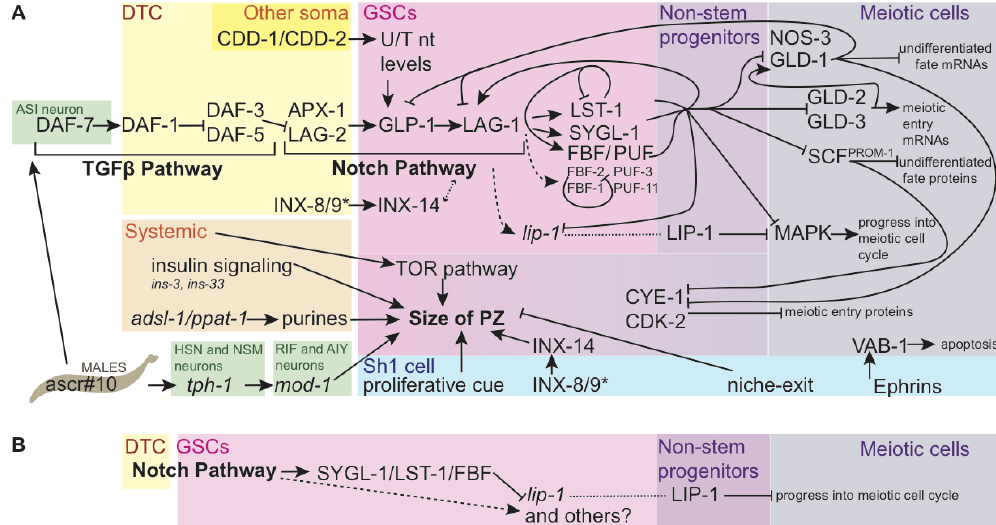
Figure 2. Genetic regulation of cell fate and size of the progenitor zone. ( A ) Genetic regulation of cell fate and size of the progenitor zone. Direct connections are indicated with solid black arrows. Indirect regulation is shown by dashed arrows. Pathway members are clustered with those that are thought to interact at the same step in the pathway, but lines originate and terminate only where there is genetic evidence of interaction. Coalescing arrows show cooperative activity at the next step of the pathway. GLP-1 Notch intracellular domain (NICD) is not shown separately. Colored boxes show sites of action for the genes and proteins named within. Inputs are also shown that a ff ect the size of the PZ, but for which pathways of action have not yet been fully explained; the size of the PZ may be a ff ected by germ cell progress through di ff erentiation as well as proliferation. While regulation is occurring at multiple steps of transcription, translation, and protein-protein interaction, the illustration names proteins in most cases; lip-1 is an indirect target of Notch in the stem cell region, but is post-transcriptionally repressed by FBF complex there, leading to LIP-1 accumulation in proximal undi ff erentiated germ cells (see ( B ), [67]). The many genes that regulate the cell cycle in mitotic germ cells are not shown here, nor are components of the meiotic machinery. The many known components of the insulin and TOR pathways are also not shown. FBF targets from [56]. LST-1 autoregulation from [54]. SYGL-1 / LST-1 promotion of FBF-2 and LAG-1, and GLD-1 repression of LAG-1 from [68]. Insulin ligands from [69]. SCF PROM − 1 pathway from [61]. CYE-1 repression of GLD-1 from [62,63], repression by GLD-1 from [62,70]. Nucleotide biosynthesis from [71,72]. Ephrin-apoptosis pathway from [73]. Innexins from [74]; * indicates that innexin presence is required in at least one of DTC or Sh1 (innexins’ role in potentiating germ cells for di ff erentiation is not shown). PUF-3 and PUF-11 from [50]. Direct coregulation of gld-1 mRNA by SYGL-1 and LST-1 with FBF from [53]; interaction between the direct targets of Notch signaling are shown in cooperation with FBF for other known FBF targets because SYGL-1 and LST-1 are redundantly required for Notch signaling to maintain the stem cell pool [52], though the roles of SYGL-1 and LST_1 in these regulatory events have not yet been experimentally validated. Male signals from [75,76]. ( B ) Simplified sub-circuit showing how indirect transcriptional targets of Notch signaling that are post-transcriptionally inhibited by SYGL-1 / LST-1 / FBF complex can restrict protein products to the non-stem progenitor